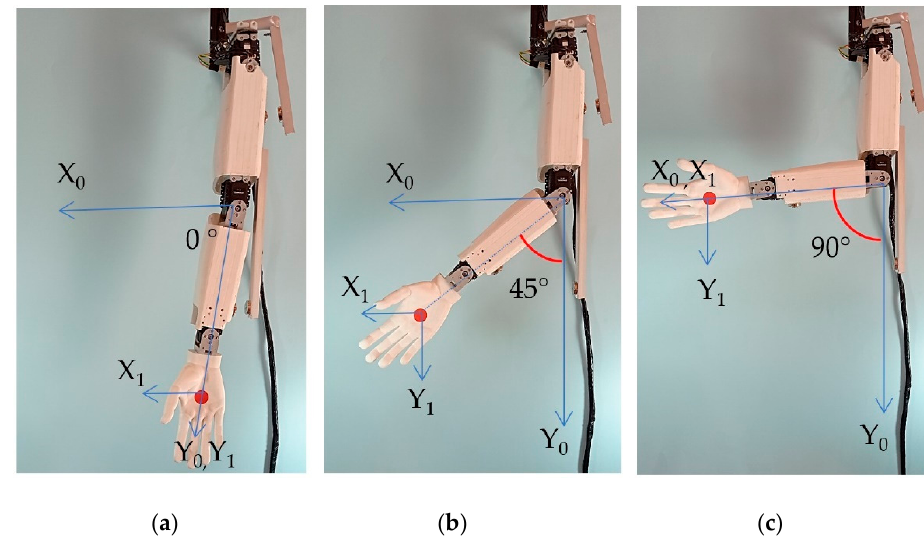
Figure 13. Flexion and extension trajectories: ( a ) capture at 0 ◦ , ( b ) capture at 45 ◦ , ( c ) cap-